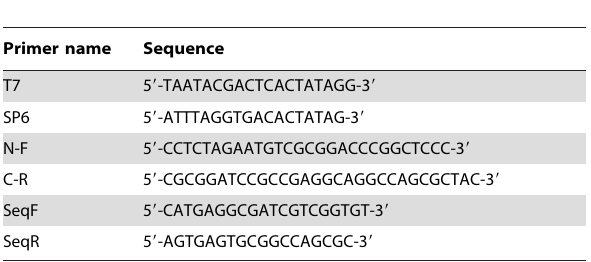
Table 2. Primer sequences for sequencing, subcloning and PCR verification.